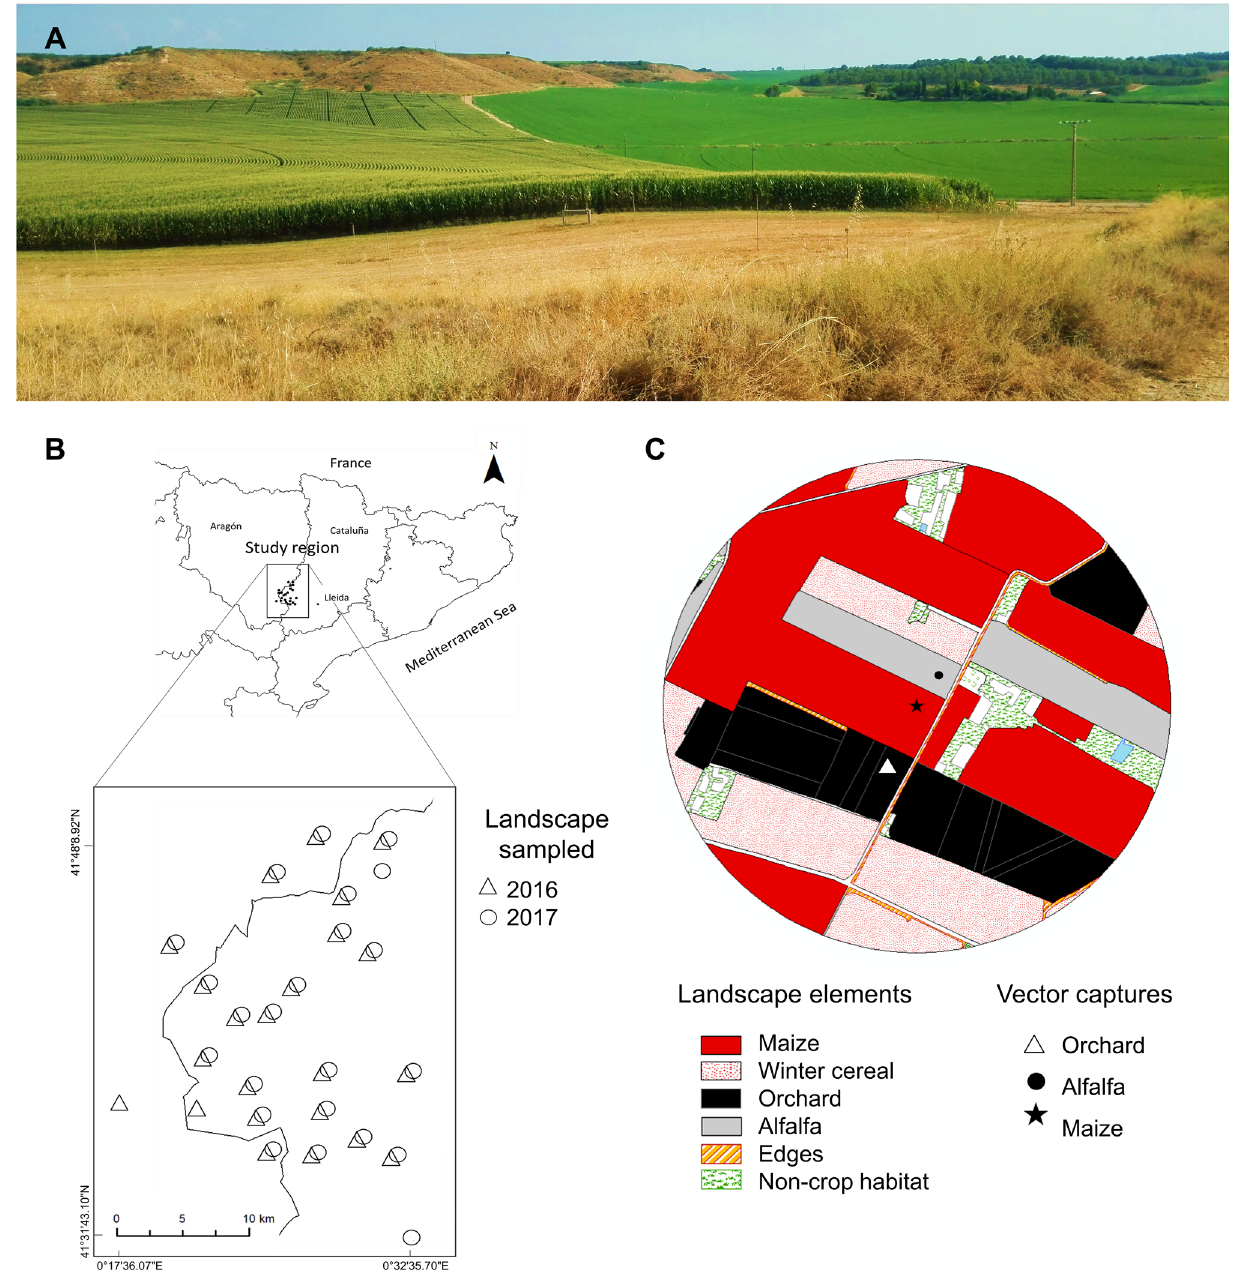
Figure 4. Study region in the Ebro Basin in northeastern Spain ( A ). Landscape sampled in 2016 and 2017 ( B ). The star, the circle and the triangle indicate the middles of the sticky yellow traps in the sampled fields used to collect MRDV vectors ( C